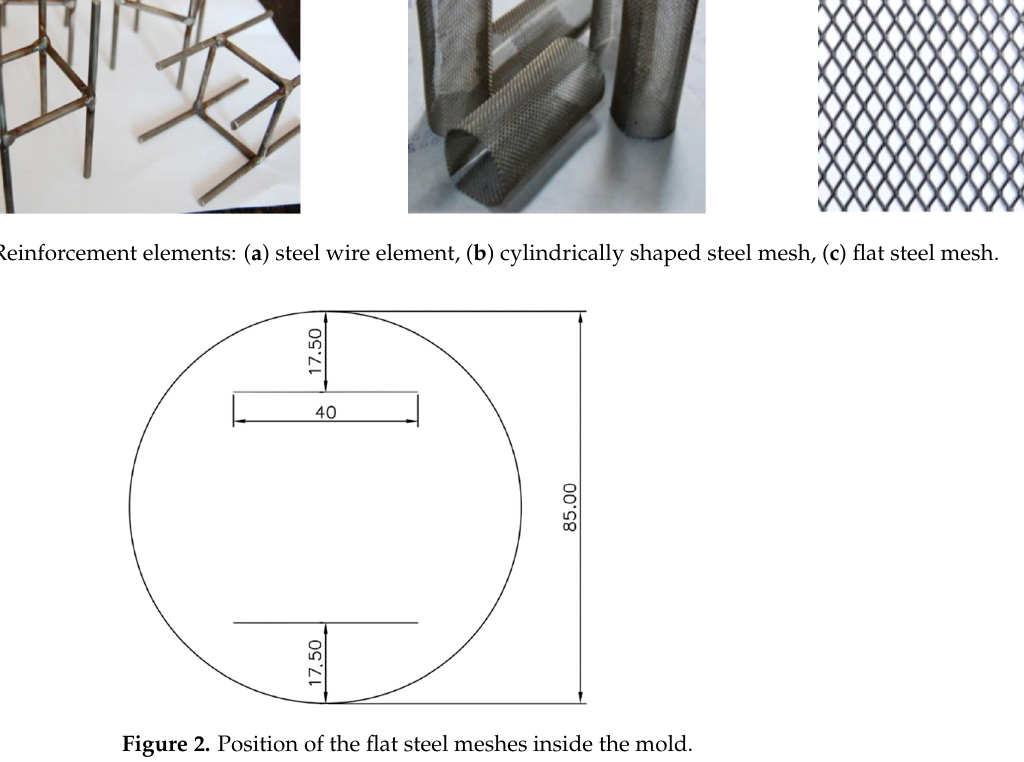
Figure 2. Position of the flat steel meshes inside the mold.